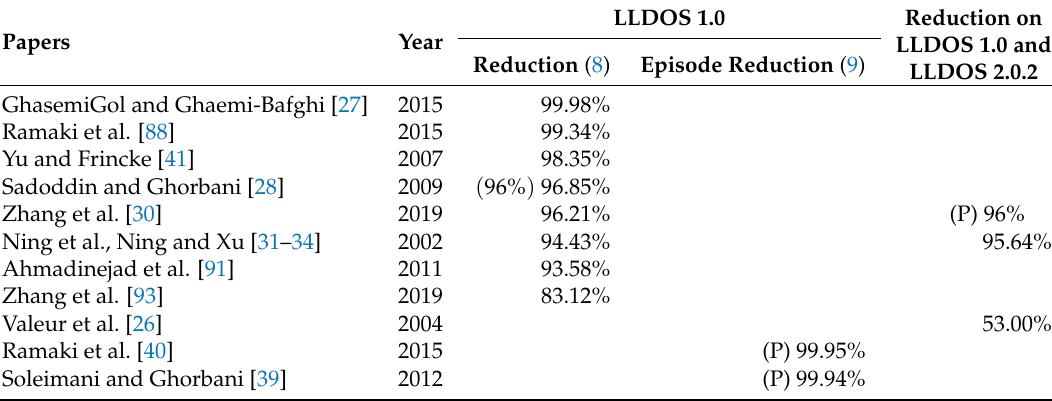
Table 5. Alert reduction calculated on the basis of results on the DARPA 2000 dataset.